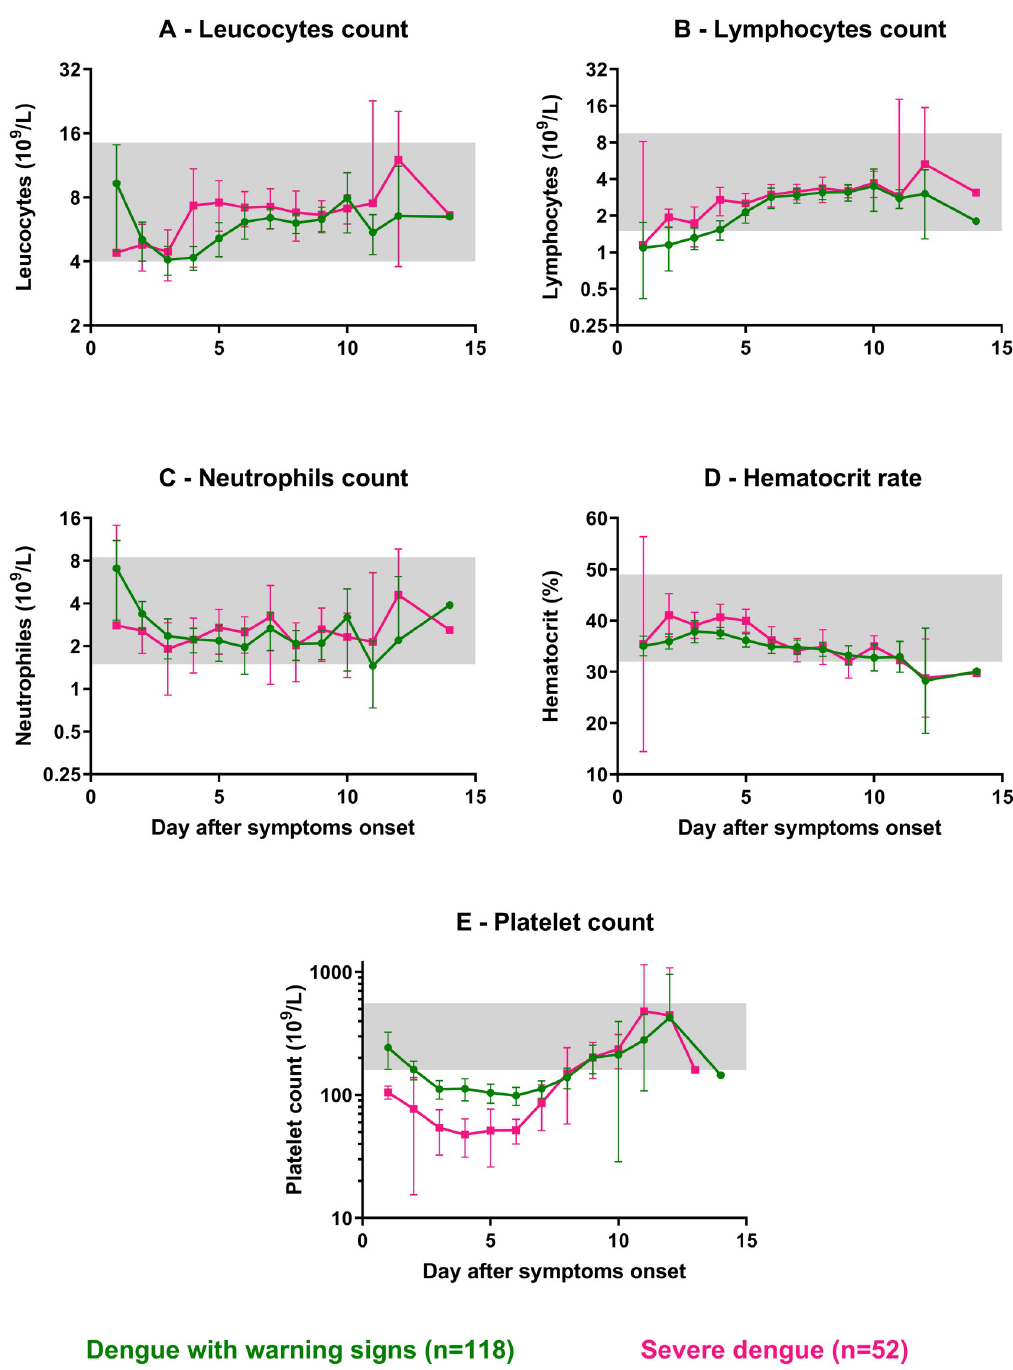
Fig 2. Hematological parameters observed in hospitalized dengue-infected patients for the adapted WHO 2009 classification scheme. Values from admission, deferverscence, and discharge visits for: dengue with warning signs (DWWS; green circles), severe dengue (SD; pink squares). ( A ) Leucocytes count (10 9 /L); ( B ) Lymphocytes count (10 9 /L); ( C ) Neutrophils count (10 9 /L); ( D ) Hematocrit rate (%); ( E ) Platelet count (10 9 /L). Each circle or square represents the mean of each variable’s observed values per day. Error bars correspond to 95% confidence intervals around the mean. Grey areas represent the normal range for each parameter. Normal ranges used for hematological parameters were obtained for children aged from 2 to 15 years old from: http://www.hematocell.fr/index.php/les-cellules-du-sang/15-les-cellules-du-sang-et-de-la-moelle-osseuse/valeurs- normales-de-lhemogramme-selon-lage/129-hemogramme-selon-lage.